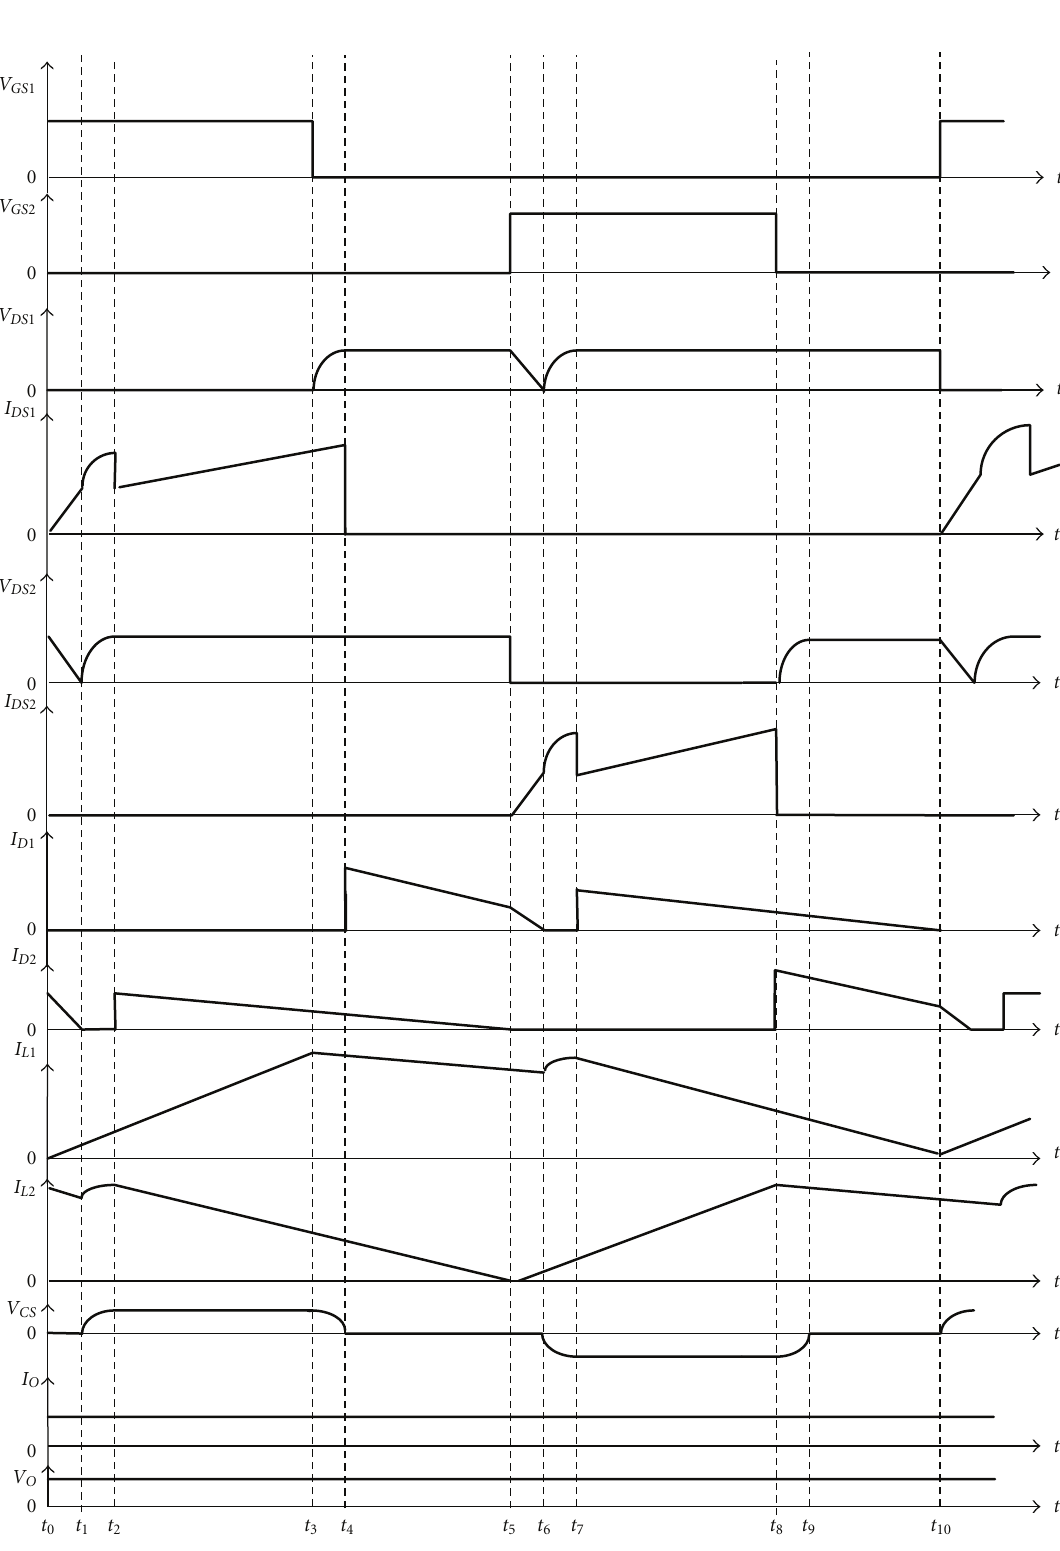
Figure 13: Key waveforms of the proposed battery charger operating over one switching